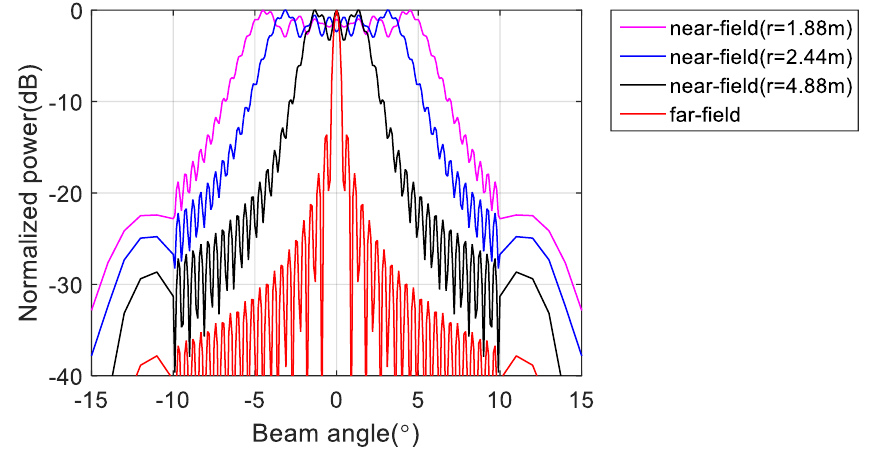
Figure 4. Beam pattern simulation for far-field and near-field (r = 1.22 m, 2.44 m, 4.88 m).